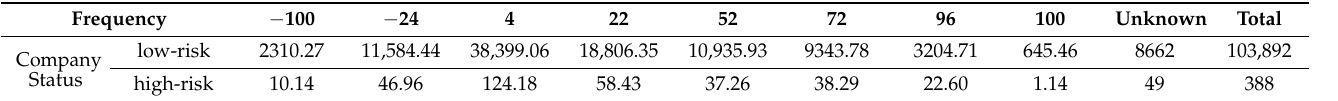
Table 1. Frequency of Operating Margin (%) rate in many referential points for low- and high-risk companies.